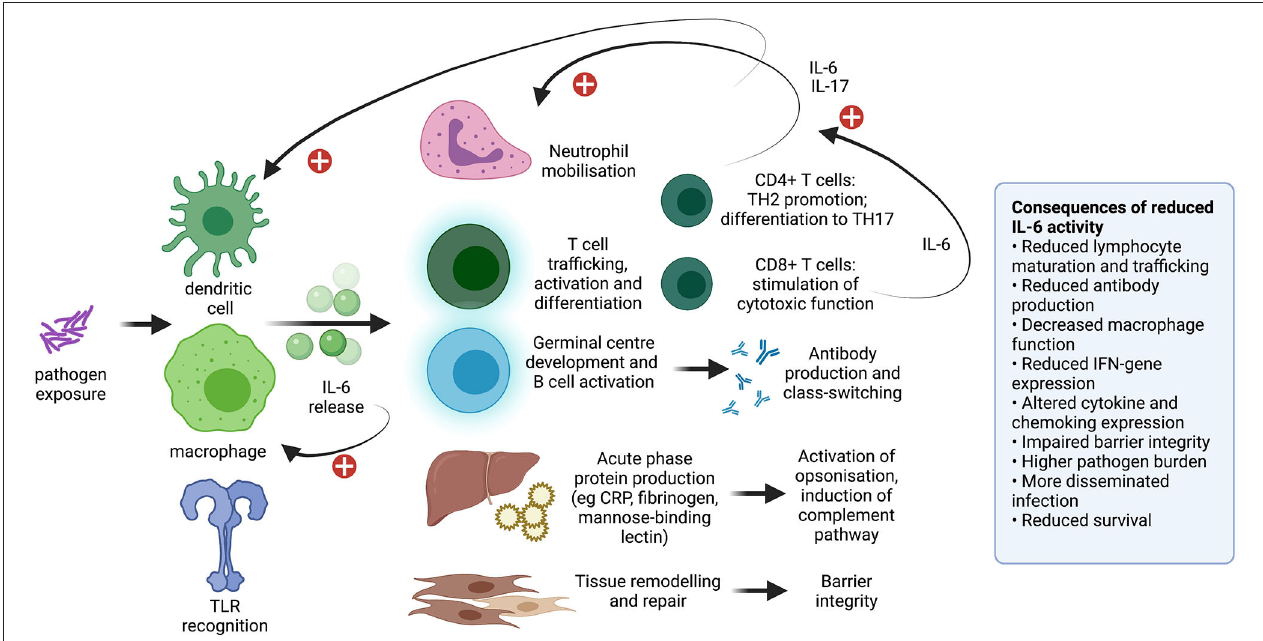
FIGURE 2 | Diagram to show the diverse influence of IL-6 on the immune system. Impact includes monocyte differentiation into macrophages, co-ordination of the neutrophil and lymphocyte response, production of acute phase proteins, and tissue remodelling and repair. Consequences of reduced IL-6 activity have been observed in animal models ( 27–35) and in IL-6 blockade using monoclonal antibodies including TCZ. This topic is previously reviewed (2). IL, interleukin; TLR, toll like receptor; CRP, C-reactive protein; IFN, interferon. Plus signs indicate a positive feedback loop. Created with BioRender.com.